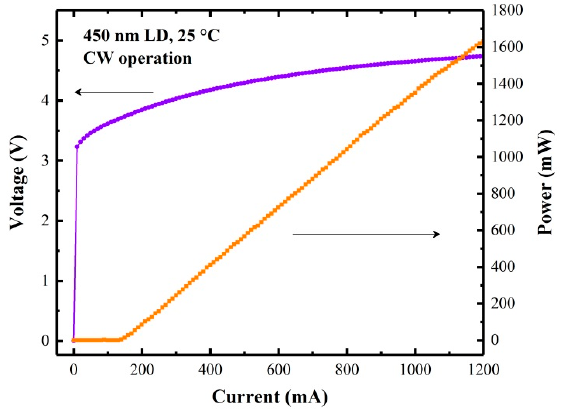
Figure 1. Nitrogen dioxide (NO 2 ) absorption cross sections between 300–650 nm (blue) and the emission spectrum of the used laser diode (LD) (red).